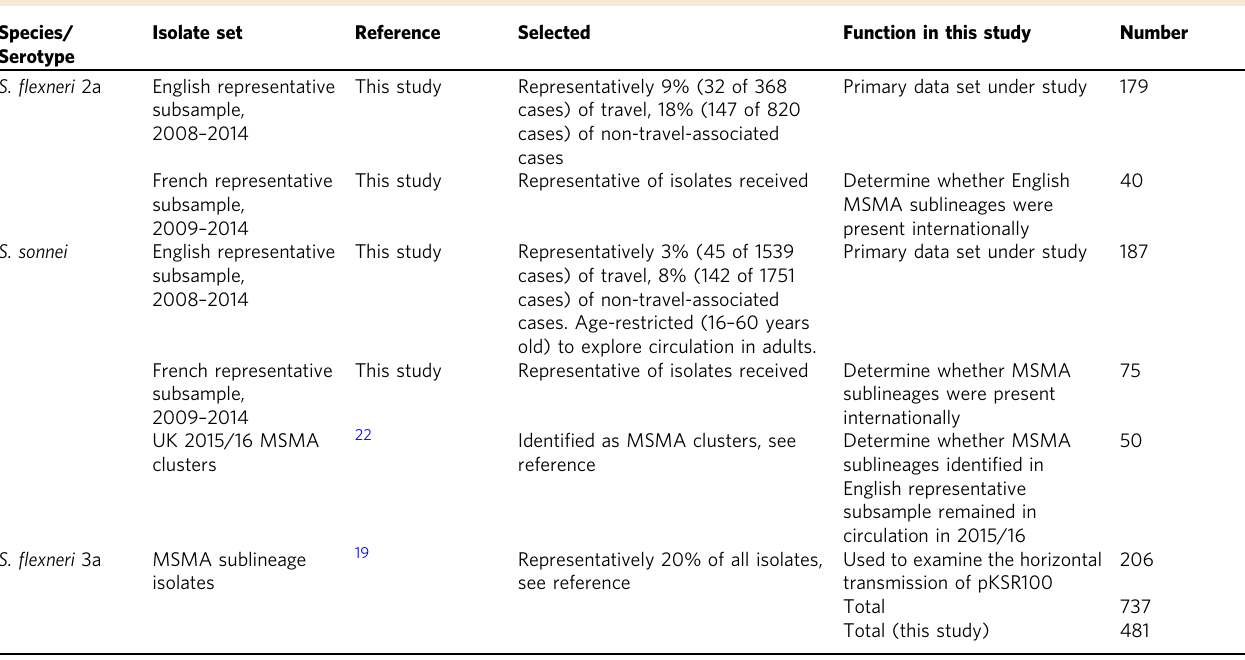
Table 1 Shigella sp . isolates used in this